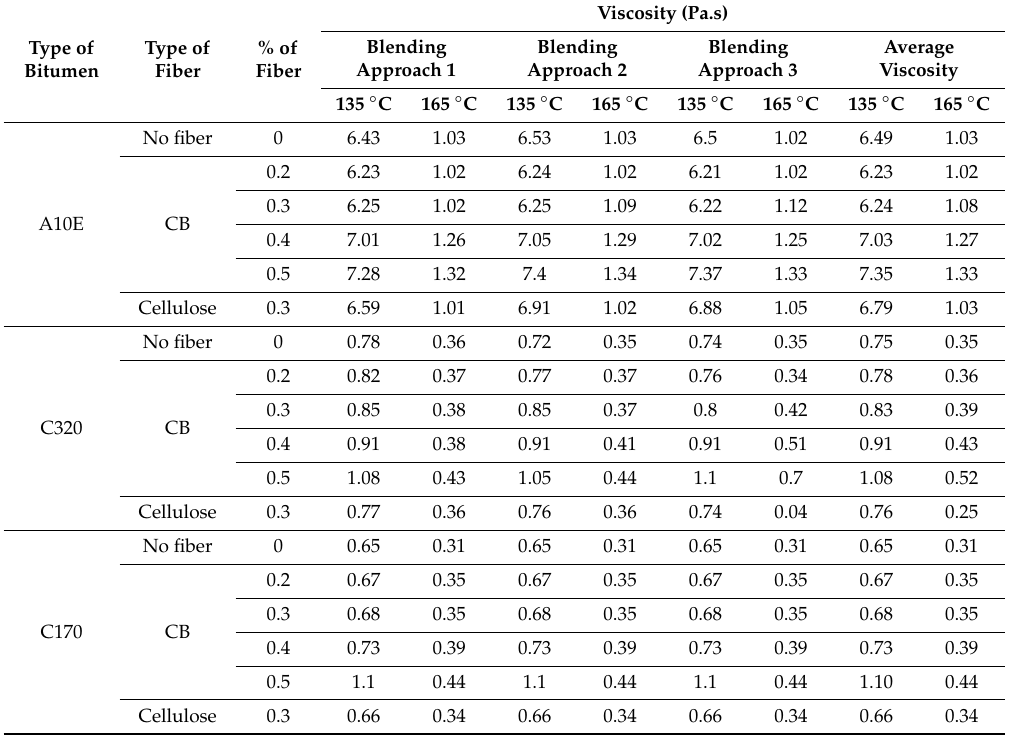
Table 6. Viscosity test results of the samples.